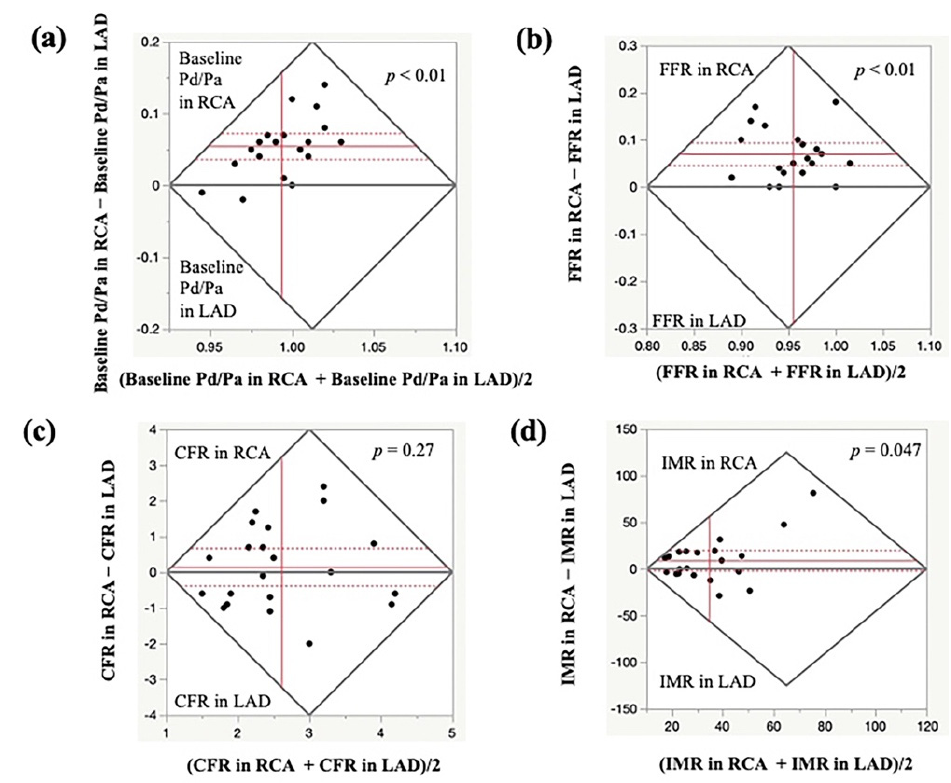
Figure 3. Comparison of MVFT data in the LAD and RCA. The Bland–Altman plots show the baseline Pd/Pa ( a ), FFR ( b ), CFR ( c ) and IMR ( d ) in the LAD and RCA. The baseline Pd/Pa, FFR and IMR were significantly higher in the RCA than in the LAD, whereas no significant difference was observed in the CFR values between the LAD and RCA. CFR, coronary flow reserve; FFR, fractional flow reserve; IMR, index of microcirculatory resistance; LAD, left anterior descending coronary artery; MVFT, microvascular vasodilatory function test; RCA, right coronary artery.